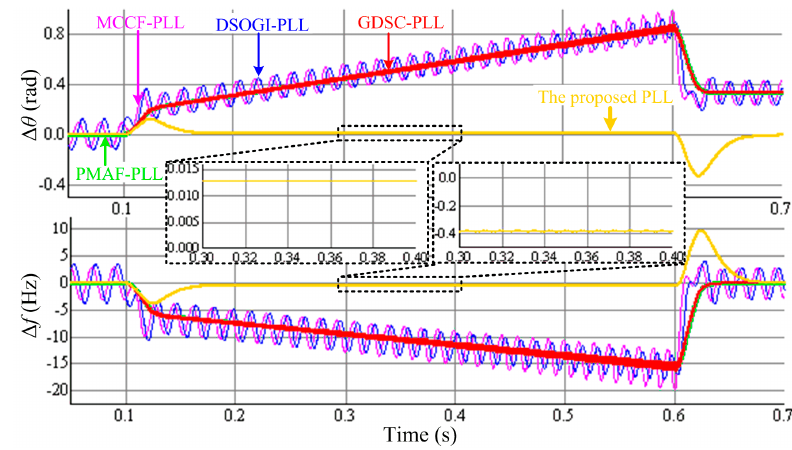
Figure 15. The comparative experimental results under ramp-changed frequency. Table 2. Dynamic performance index.